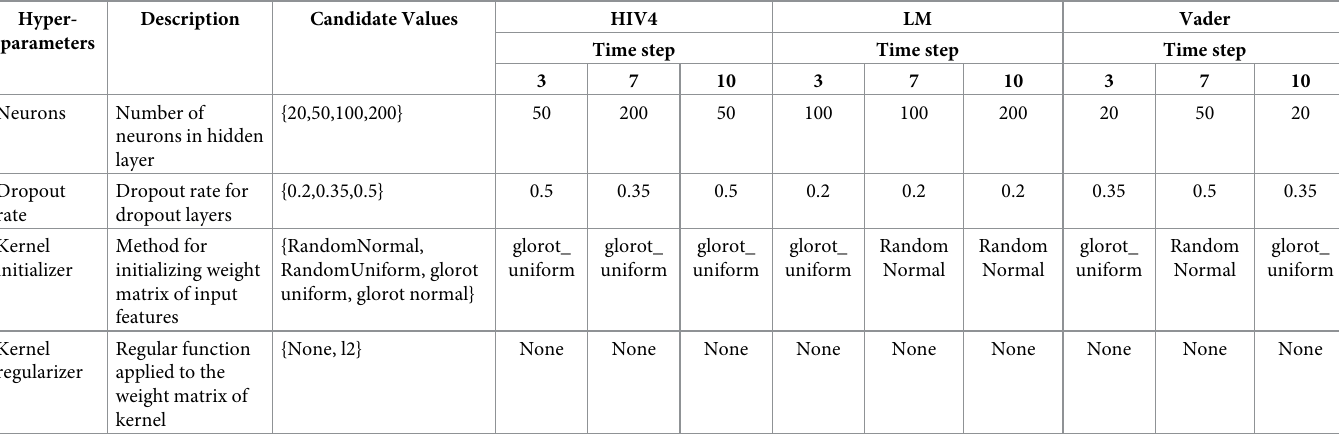
Table 4. Baseline model’s (LSTM) optimized hyper-parameters